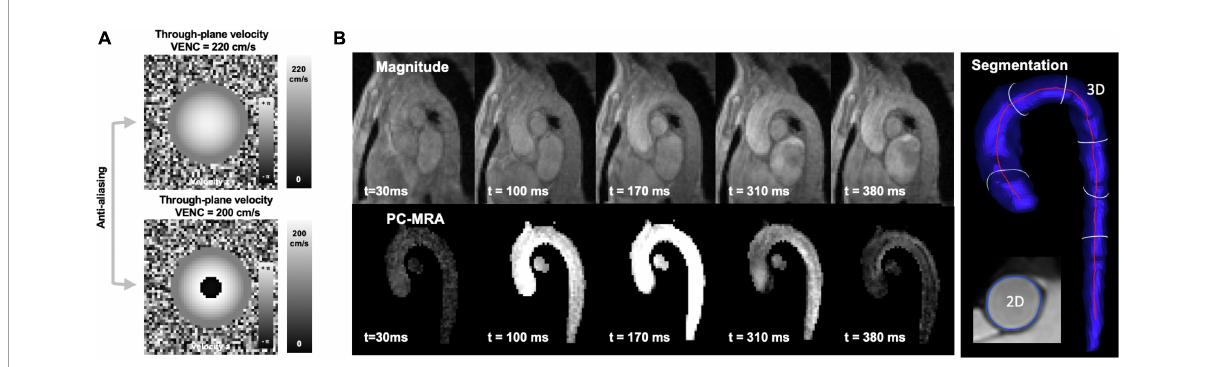
FIGURE3 (A) Simulated parabolic flow with a central peak velocity of 220 cm/s and the aliasing effect create in the phase-difference image and the velocity map when a lower VENC e.g., of 200 cm/s is chosen. (B) Temporal evolution of the magnitude and PC-MRA signal in an aortic 4D flow MRI dataset. Magnitude images do not allow for fast segmentations based on thresholding as blood and tissue have a similar contrast. PC-MRA images lose their signal when there is no apparent blood flow e.g., during